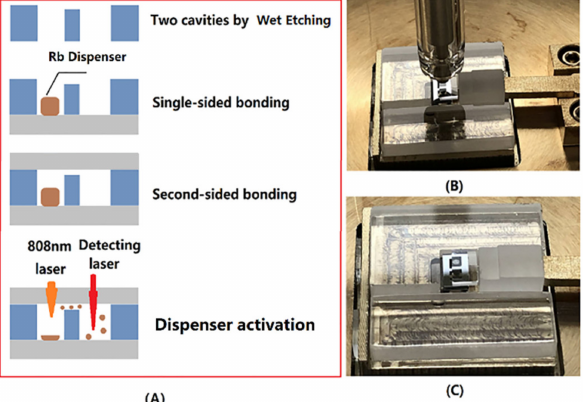
Figure 3. ( A ) Sealing process of vapor cell: Single-sided anodic bonding and Rb dispenser storage, Second-sided bonding, dispenser activating and ( B ) single-chip bonding by the customized bonder with electrode and pressure device, and ( C ) single-chip bonding with upper glass and lower silicon.